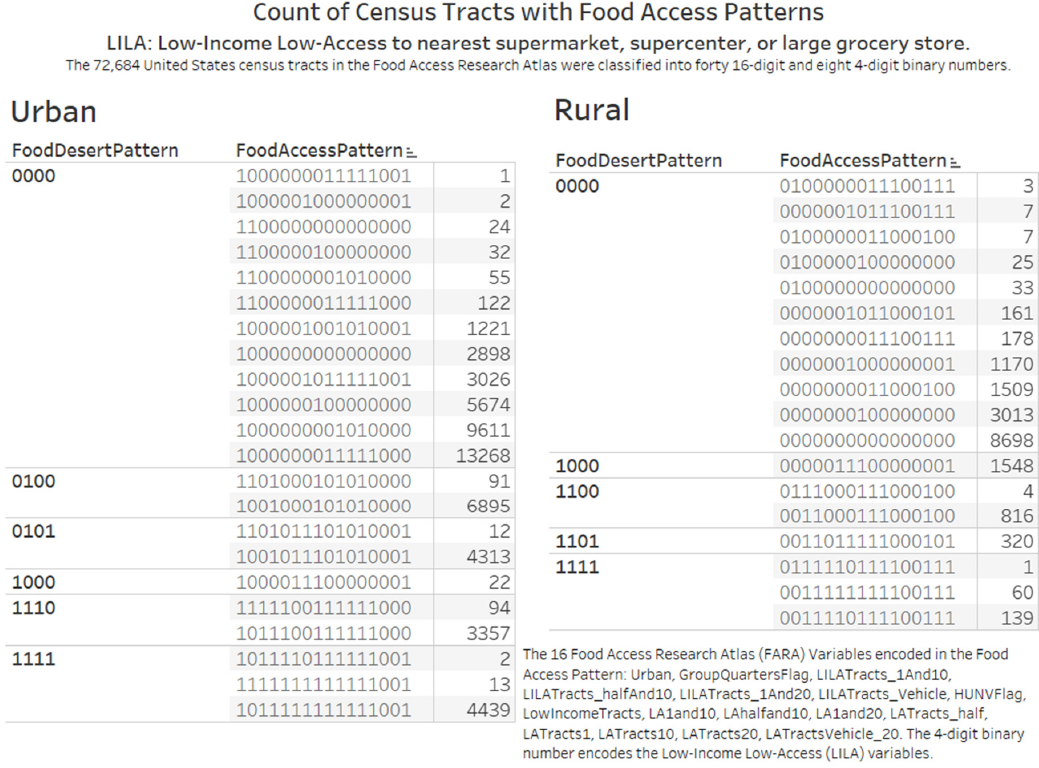
Figure 3. Groups of census tracts in the United States according to patterns of food access measures.